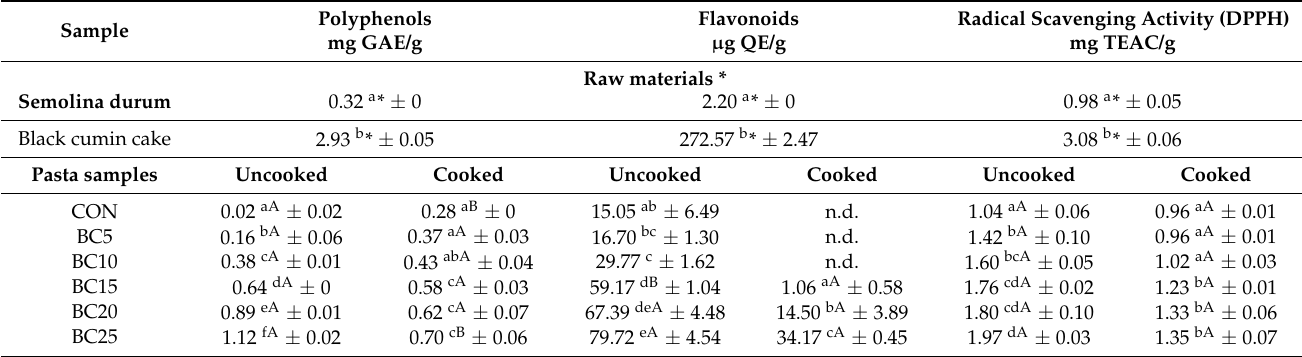
Table 4. Total polyphenol and flavonoid content and antioxidant activity of pasta.